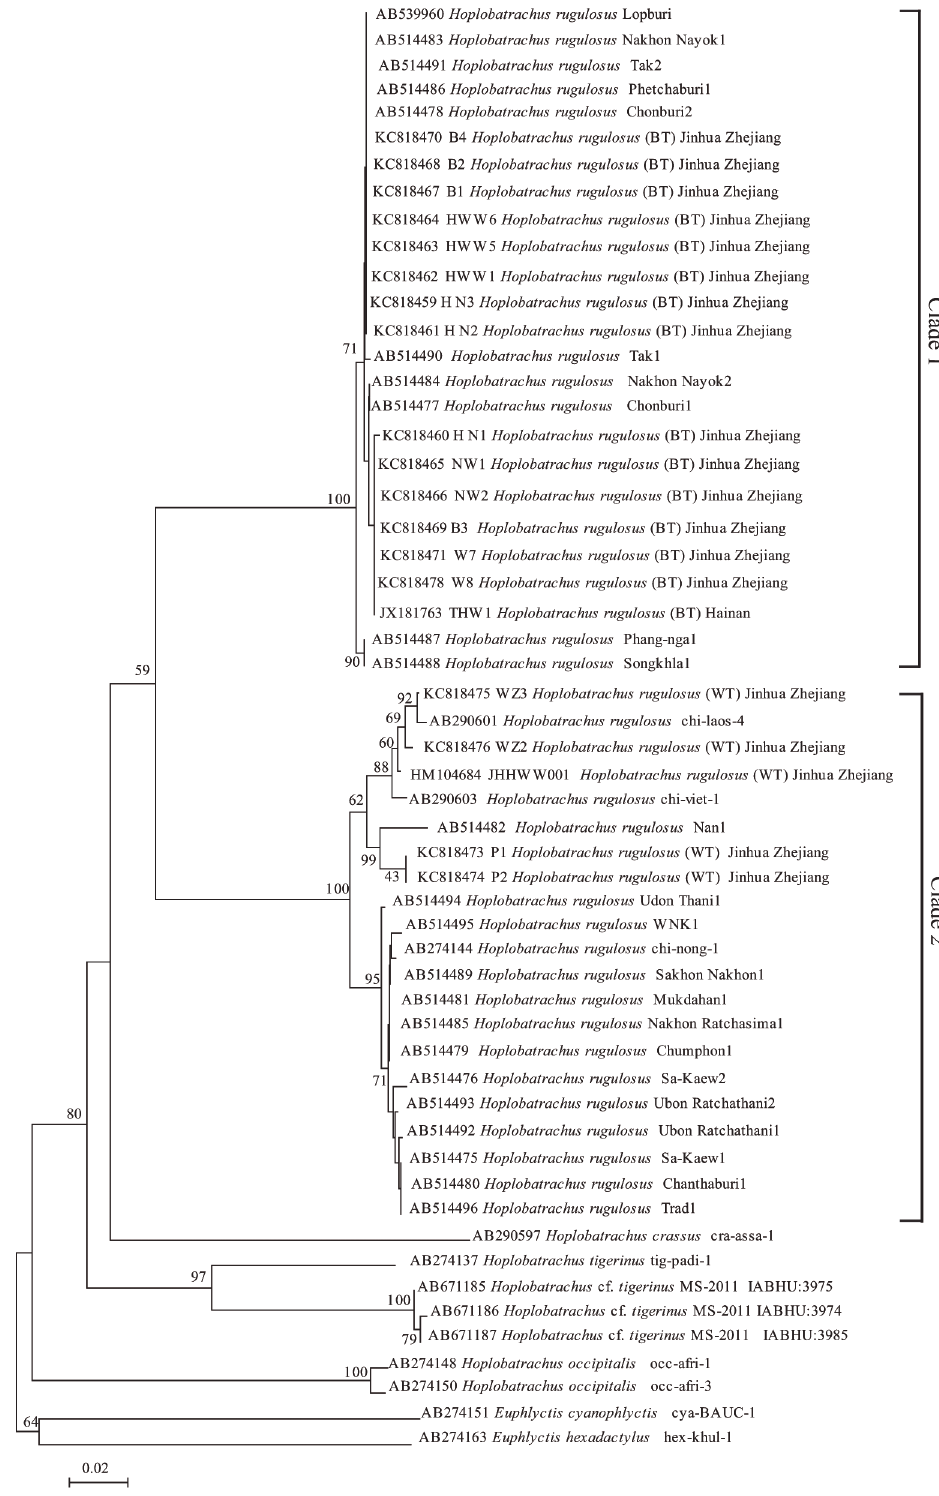
Fig 4. Phylogenetic relationships among Hoplobatrachus . Phylogenetic analysis was carried out for the 41 tiger frogs using the Cyt b gene. The tree was rooted with two out-groups ( E . cyanophlyctis and E . hexadactylus ). Numbers at the nodes are NJ bootstrap